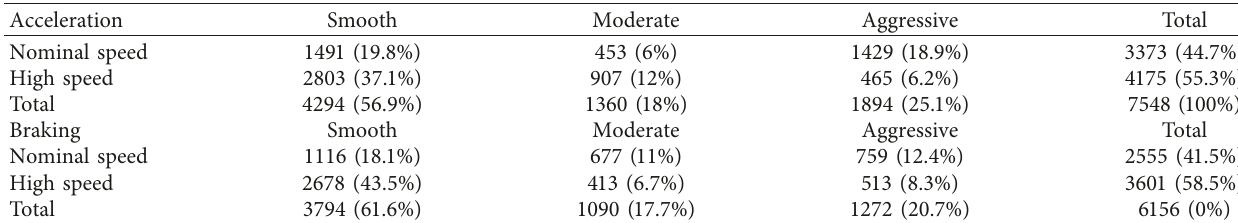
Table 9: Proportion of maneuvers shared by each pattern.